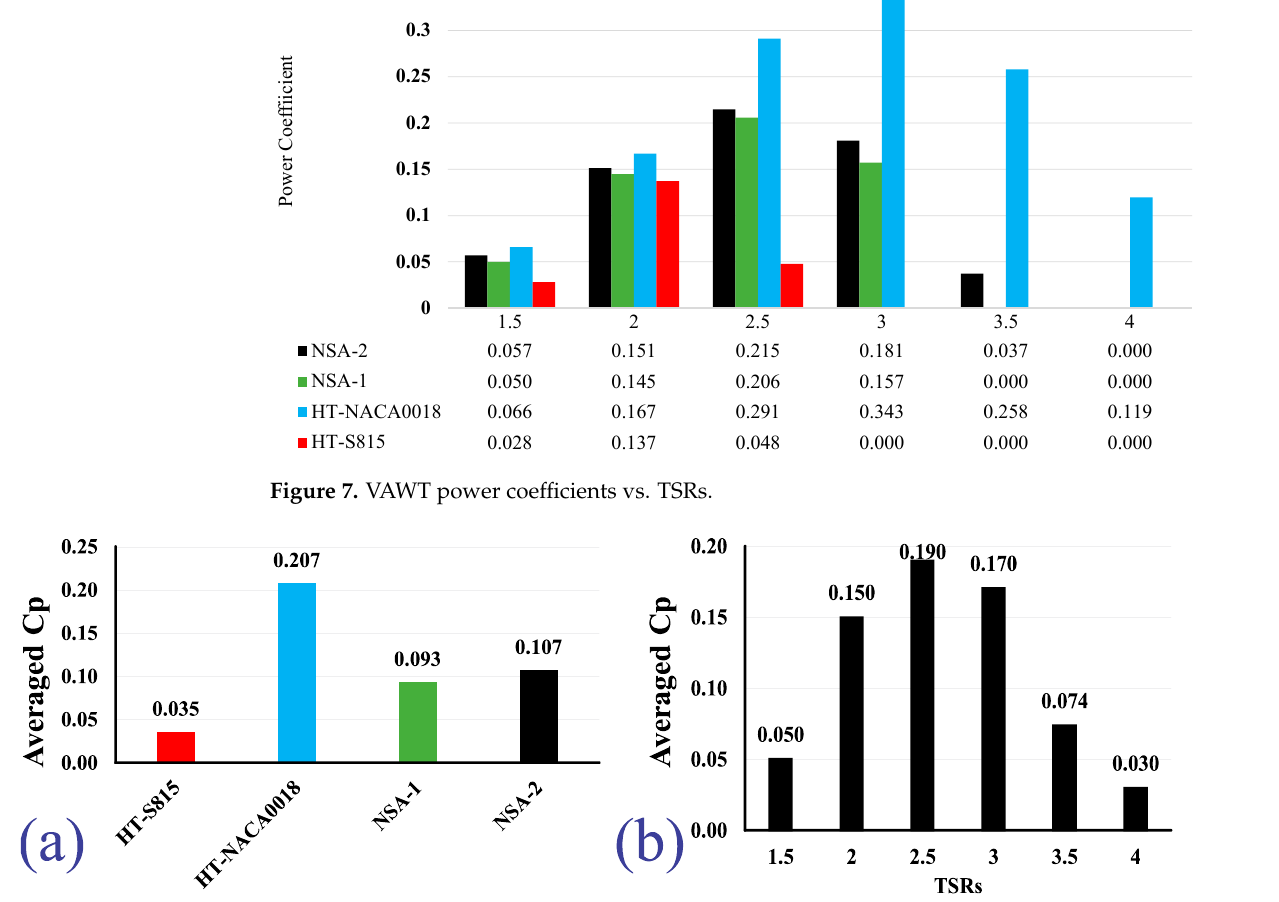
Figure 8. Averaged power coefficient: ( a ) based on all TSRs, ( b ) based on all VAWTs.